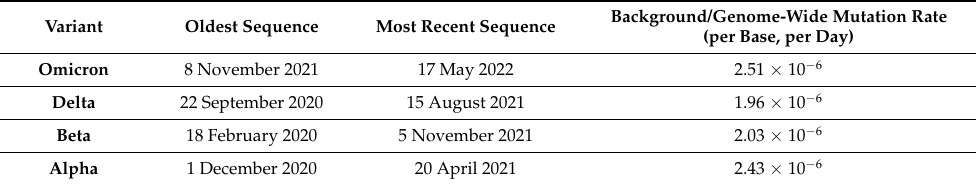
Table 2. Dates of sequences from each variant as well as calculated background mutation rate. Previous reports are 2.38E-06 per base per day.